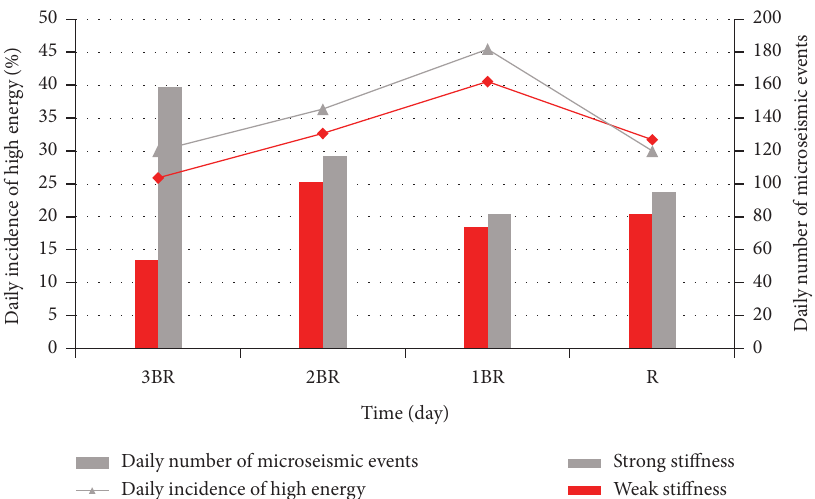
Figure 4: Characteristics of daily microseismic events and high energy incidence in rockburst